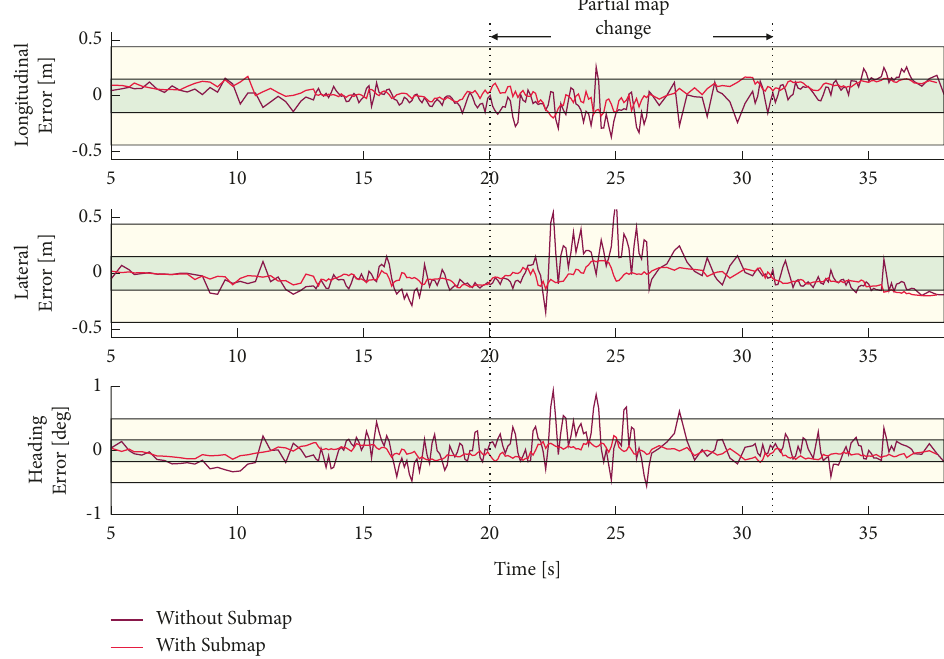
Figure 19: Performance of robust localization in map-changing